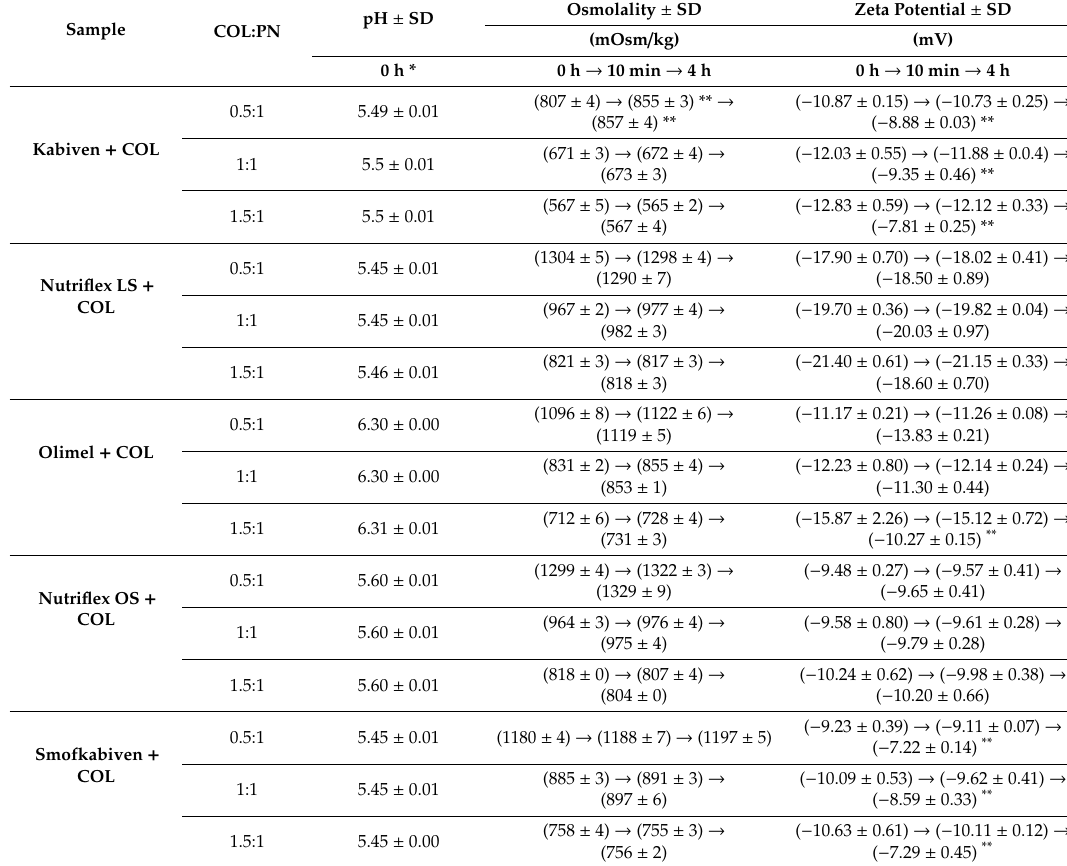
Table 1. The pH, osmolality and zeta potential of colistin–parenteral nutrition (COL-PN) samples.